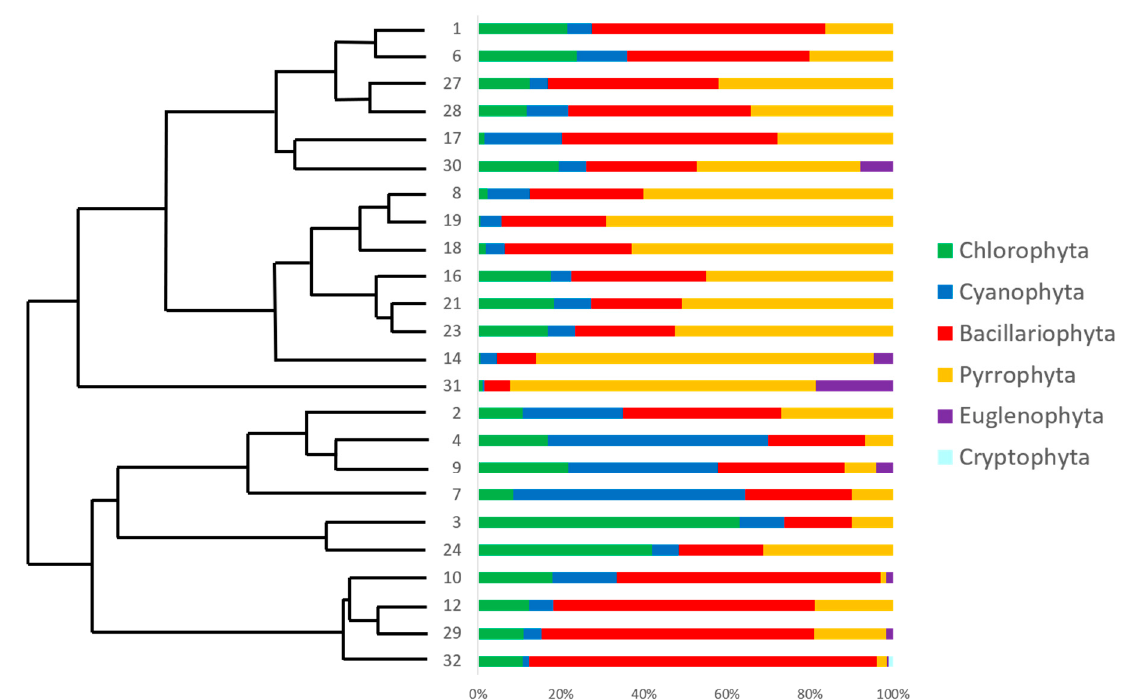
Figure 3. Cluster analysis of the phyla community structure of the 24 lakes. Numbers in the middle of the figure represent lake identities. The percentages represent the contribution of each phyla to total biovolume.